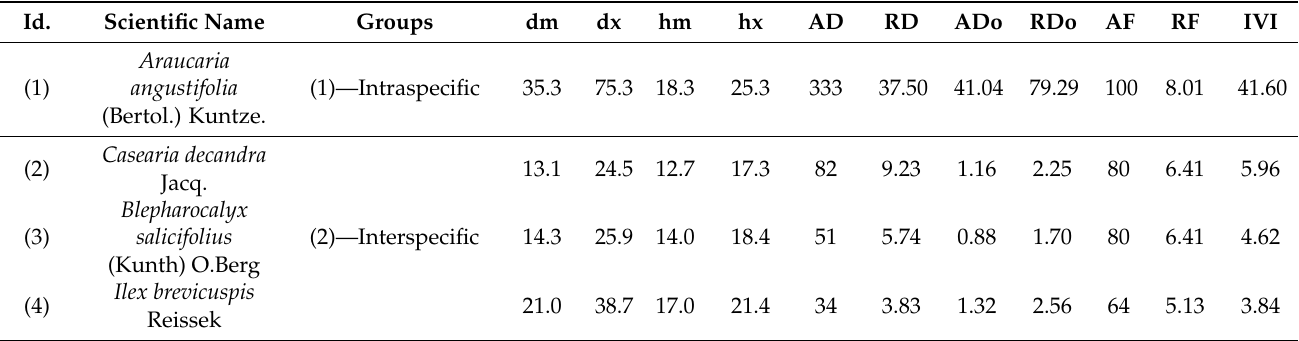
Figure 1. Growth conditions of A. angustifolia in Mixed Ombrophilous Forest in Southern Brazil. ( A ) trees inside the forest; ( B ) trees at the edge of the forest; ( C ) intraspecific competition; ( D ) interspe- cific competition; ( E ) predominance of Brazilian pine trees within the plot; ( F ) predominance of other species of native trees within the plot; ( G ) vertical forest structure with predominant intraspecific competition; ( H ) vertical forest structure with predominant interspecific competition. Photos were taken by C.A.G.F. Table 2. Dendrometric and phytosociological characterization of the species trees in plots of mixed ombrophilous forest in Southern